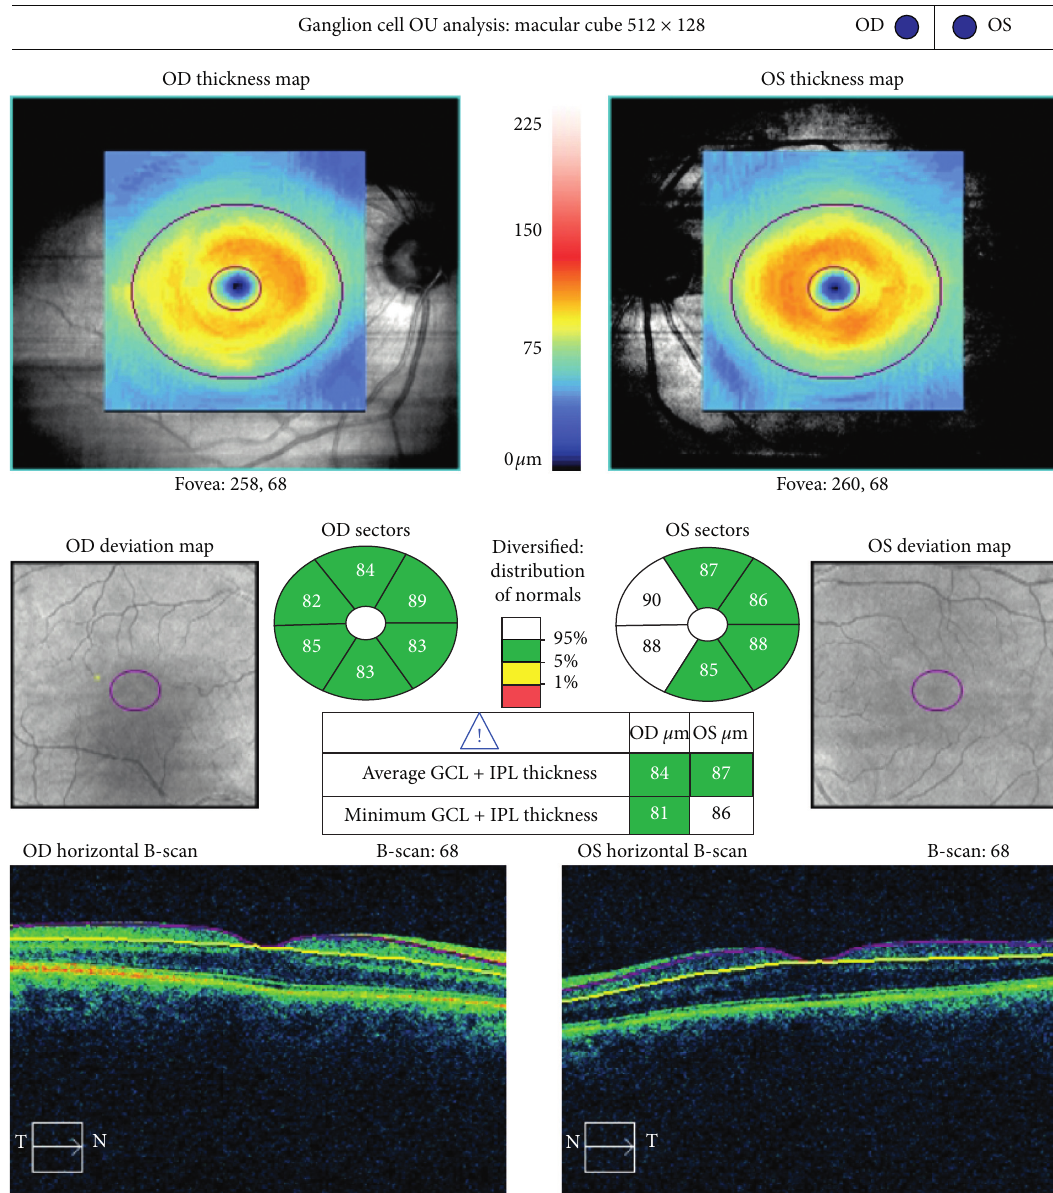
Figure 1: Preoperative Ganglion Cell Analysis of a 67-year-old